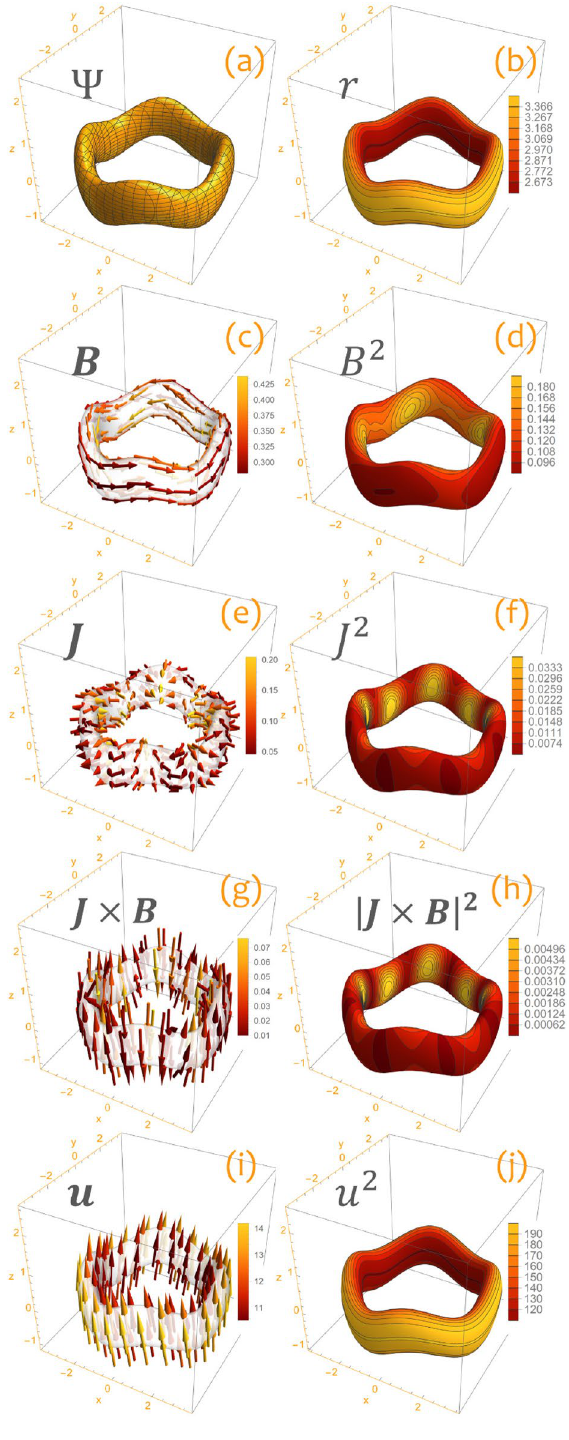
Figure 3. The quasisymmetric configuration (15) for r 0 = 3 , ǫ = 0.2 , m = 4 and E = 0.7 . ( a ) Flux surface (cid:31) = 0.1 . ( b ) Levels sets of r on the flux surface (cid:31) = 0.1 . These contours correspond to magnetic field lines. ( c ), ( d ), ( e ), ( f ), ( g ), ( h ), ( i ), ( j ): plots of the magnetic field B , the modulus B 2 , the electric current J , the modulus J 2 , the Lorentz force J × B , the modulus | J × B | 2 , the quasisymmetry u , and the modulus u 2 on the flux surface (cid:31) = 0.1 . Figure created using Wolfram Mathematica 12.2